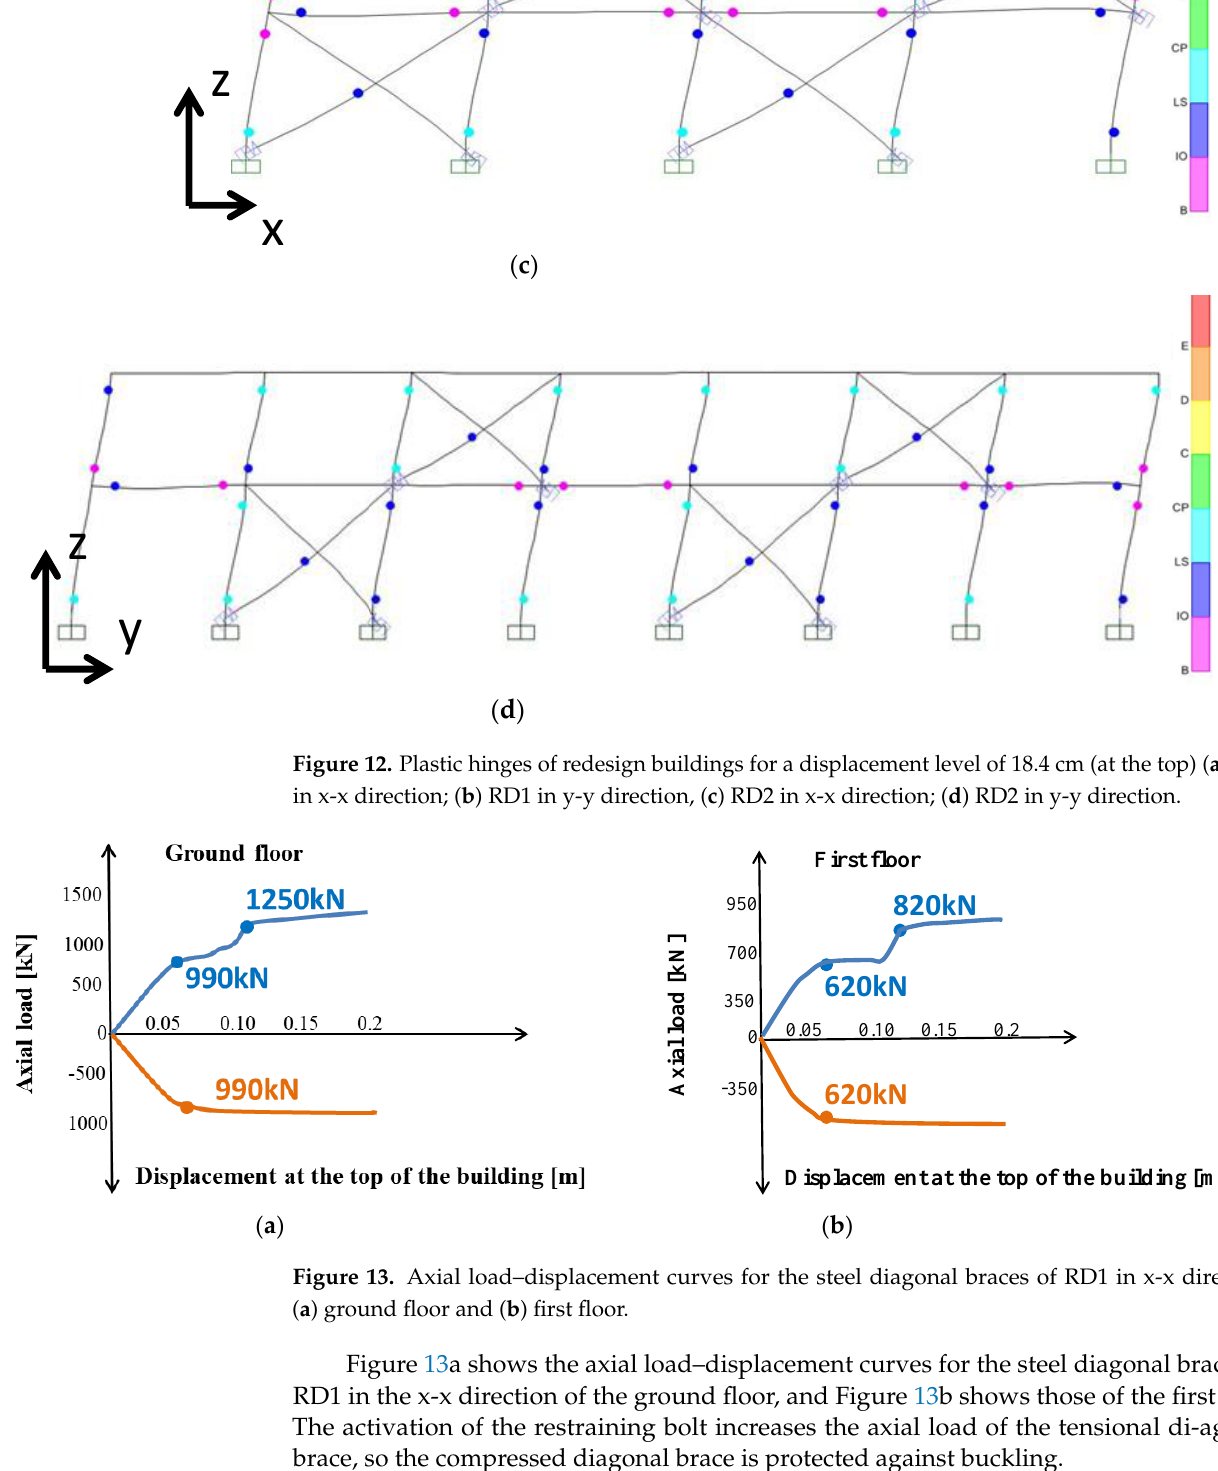
Figure 13. Axial load – displacement curves for the steel diagonal braces of RD1 in x-x direction: (a) 347 ground floor and (b) first floor.